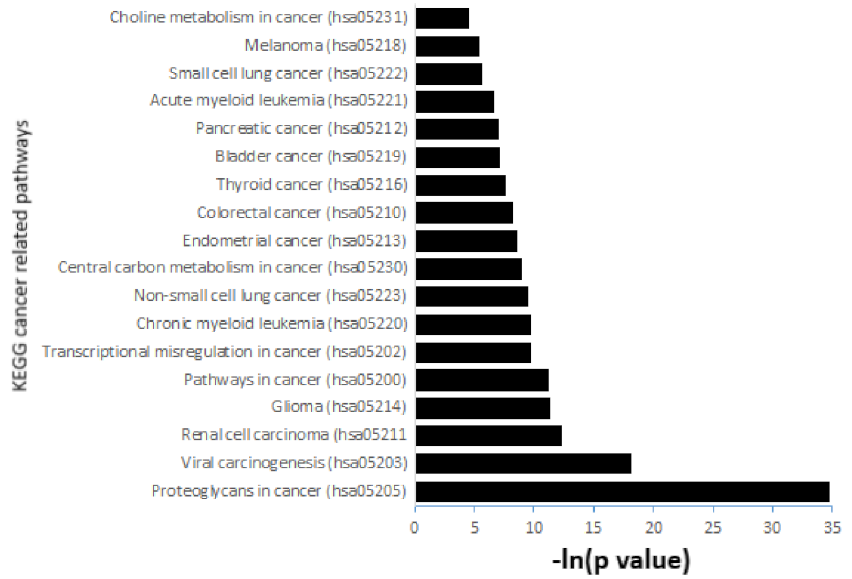
Figure 11. The KEGG pathway enrichment analysis of 11 microRNAs dysregulated in early preg- nancies destinated to develop GDM. The analysis revealed a total of 62 pathways, where at least 18 (29.03%) pathways were cancer related. The results were expressed as –ln of the p -value ( − ln( p